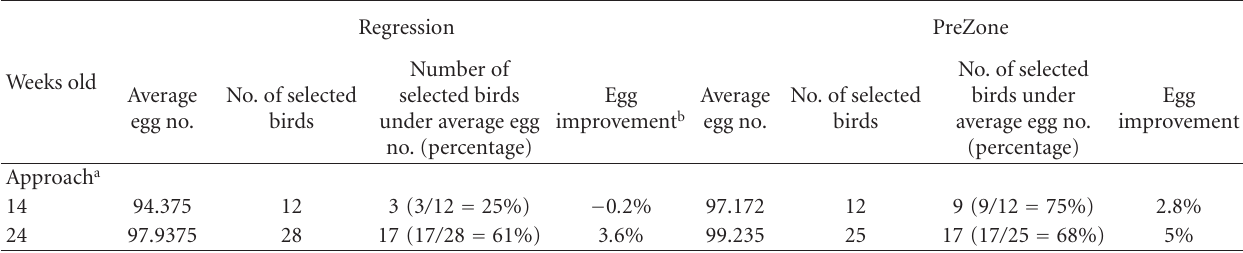
Table 9: Selection of low egg productivity in batch A of birds by regression and PreZone method.